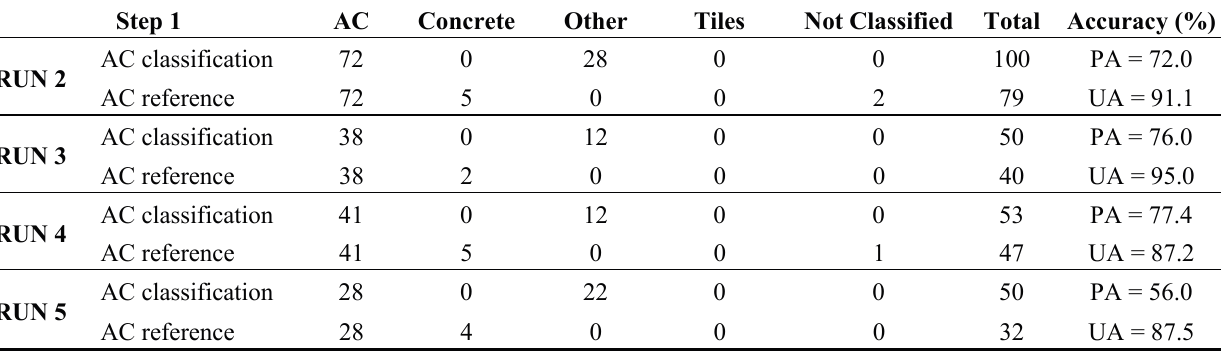
Table 1. Step 1: Classification accuracy assessment for RUN 2, 3, 4 and 5.